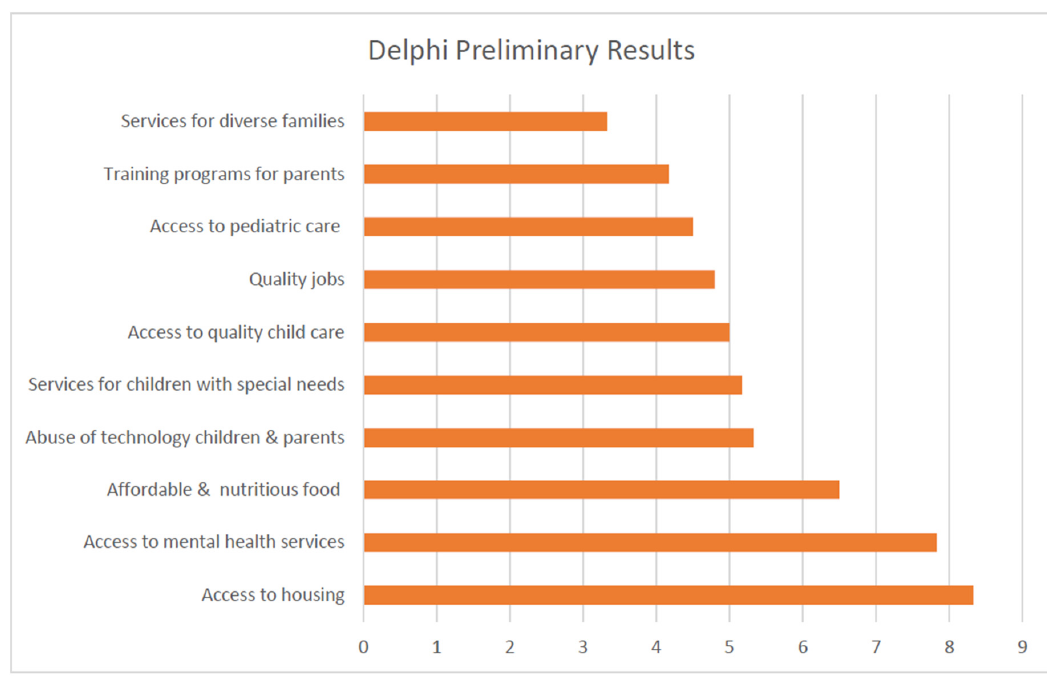
Figure A3. Delphi preliminary results.